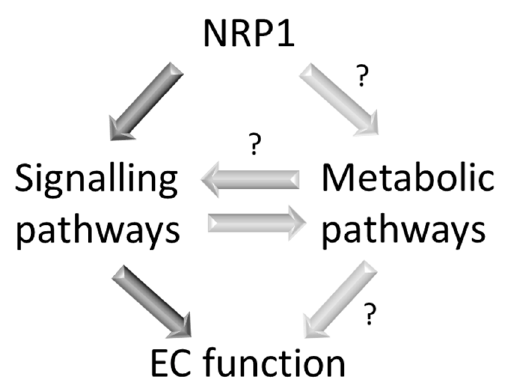
Figure 2. Regulatory functions of NRP1 in endothelial cells (ECs): Diagram illustrating established (grey arrows) and potential (shaded arrows) pathways by which NRP1 regulates EC function.